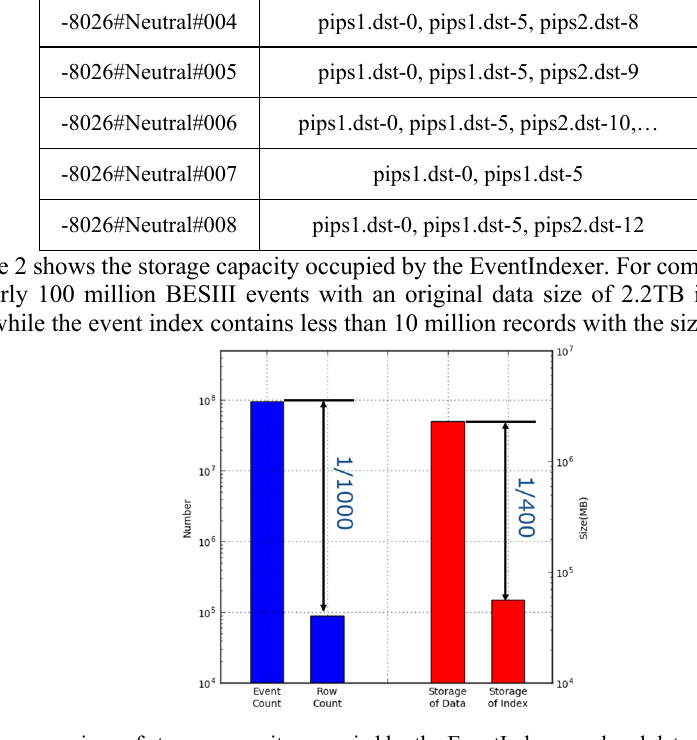
Fig. 2. The comparison of storage capacity occupied by the EventIndexer and real